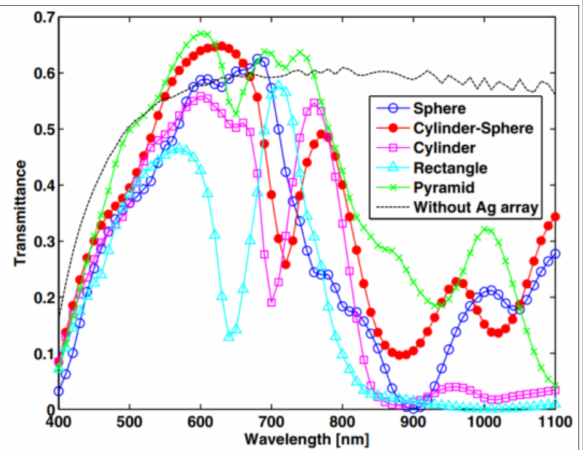
Figure 12. Bottom configuration: the silver nanoparticle arrays with individual particles shaped as rectangles or cylinders gave rise to the lowest transmittance curves [172]. Reprinted with permission from [172], 2012, American Chemical